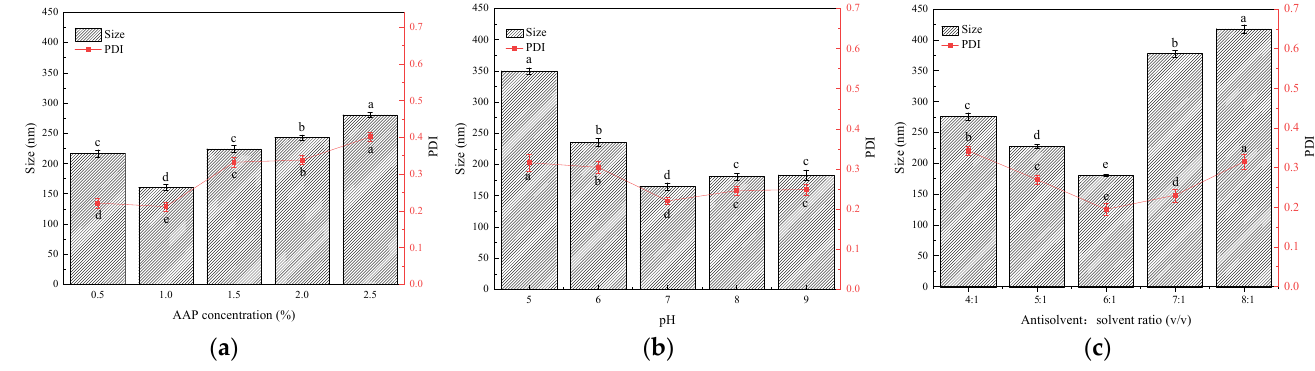
Figure 1. Effects of ( a ) different concentration of AAP, ( b ) solution pH levels and ( c ) antisolvent: solvent ( v / v ) ratios on the mean average particle size and PDI of AAP-NPs. Three independent experiments were carried out for each analysis. The data were measured by zetasizer, and results were expressed as a mean ± SD ( n = 3). Values with different letters are those found to be significantly different in the Duncan’s multiple range test ( p < 0.05).